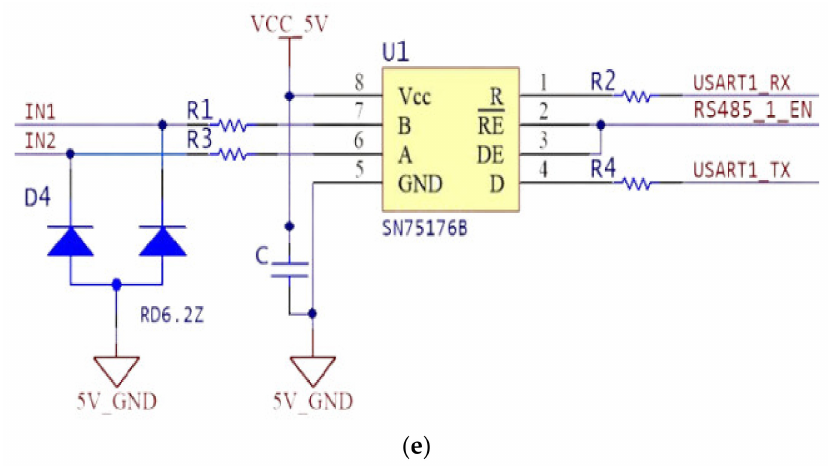
Figure 3. Smoke detector circuit diagram. ( a ) MCU STM32F051; ( b ) smoke detector; ( c ) CO sensors; ( d ) temp. sensors; ( e ) RS485.